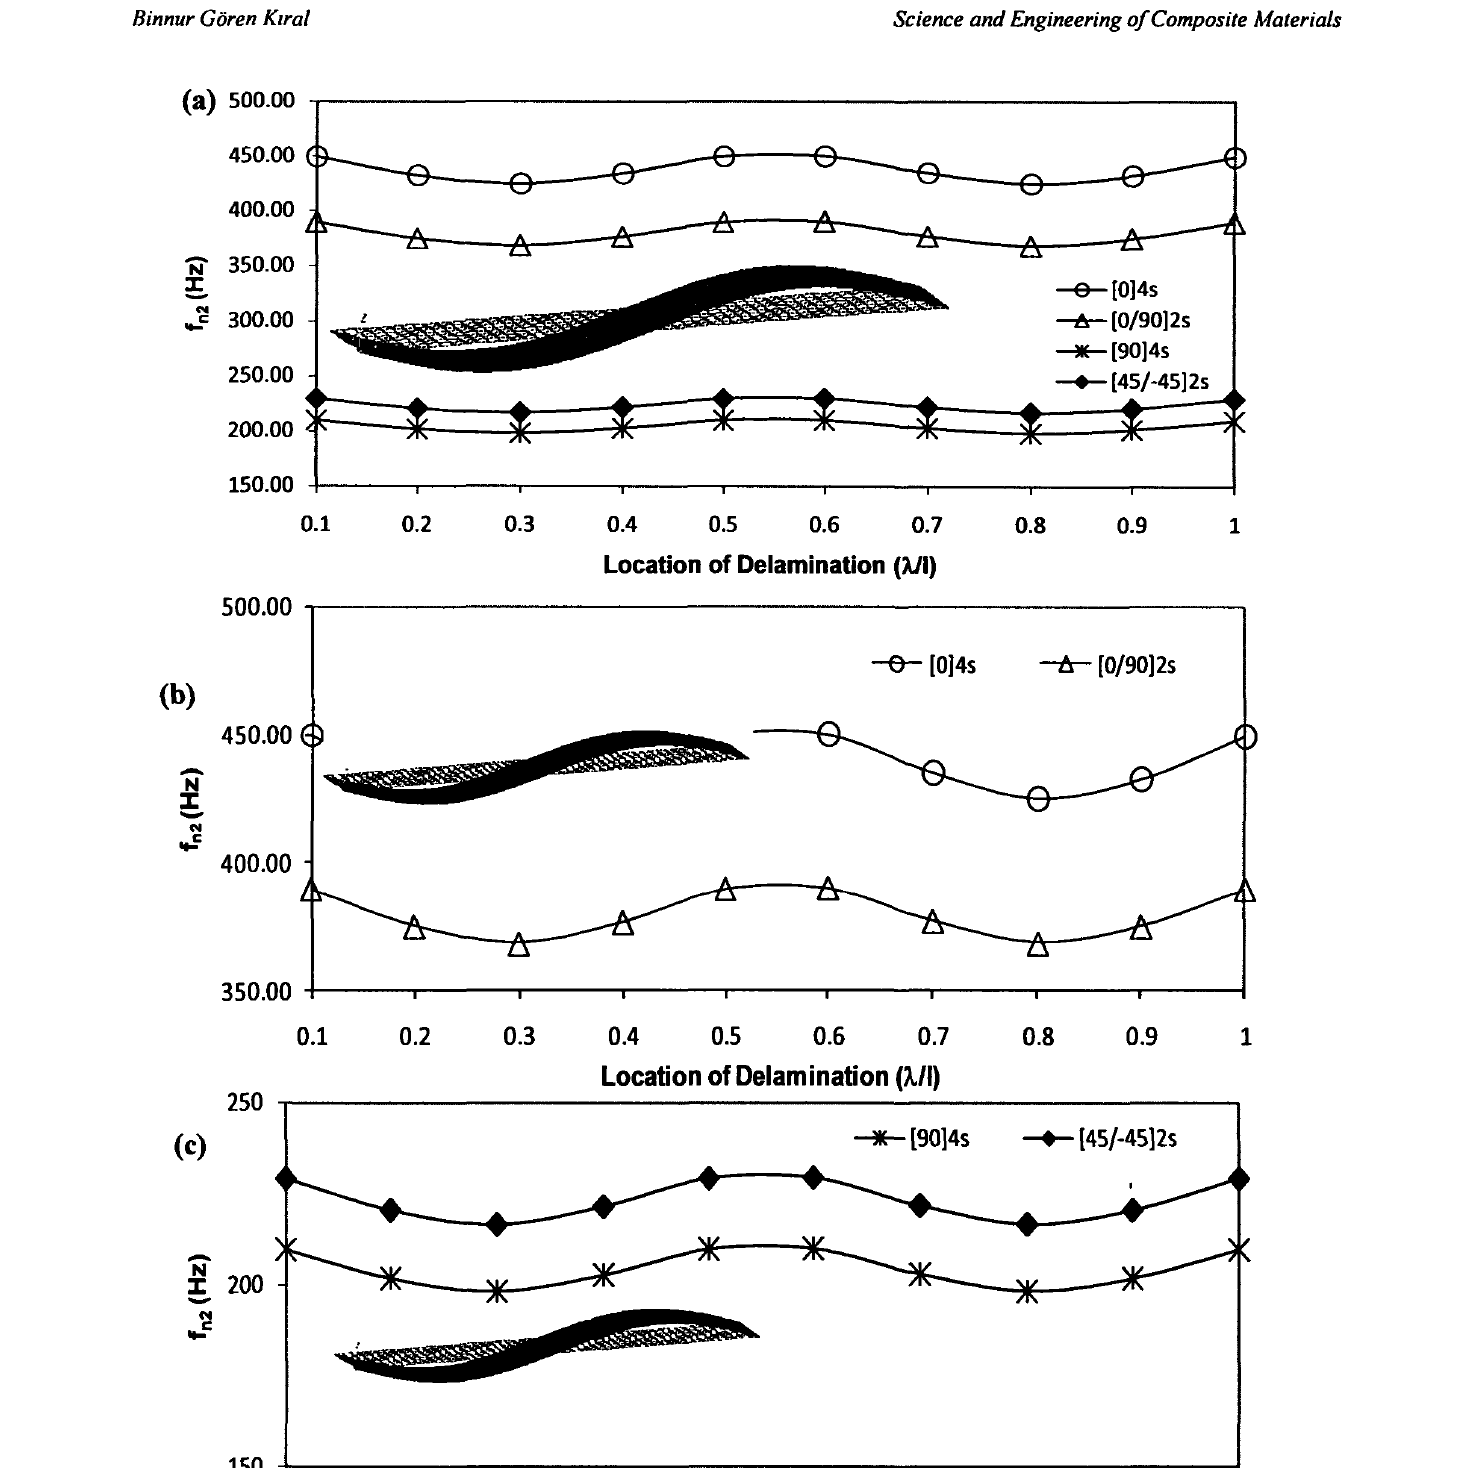
Fig. 14: Effect of the delamination location on the second natural frequency of pinned-pinned